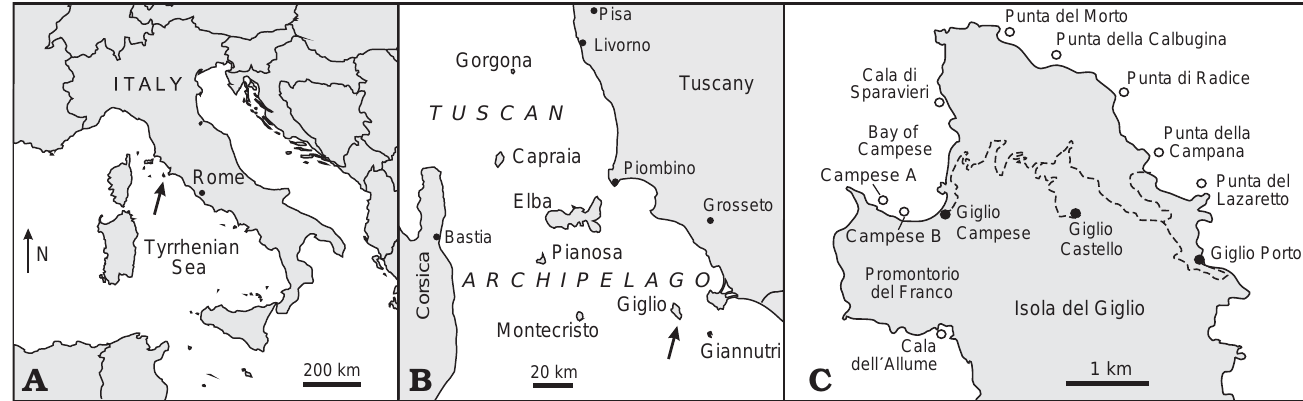
Fig. 1. Location (arrows) of study area on the map of Italy and the Tyrrhenian Sea ( A ) and Giglio Island in the Tuscan Archipelago ( B ). Location of sample points (white circles) around the northern part of the island ( C ). Modified after Grun et al. 2014.